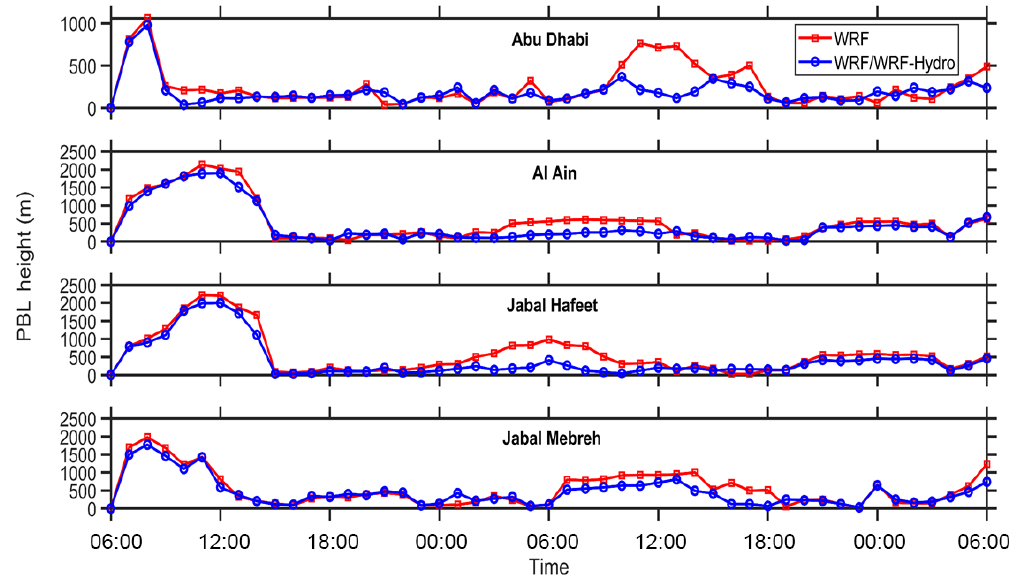
Figure 13. Planetary boundary layer (PBL) heights from WRF and WRF–WRF-Hydro simulations at each of the four